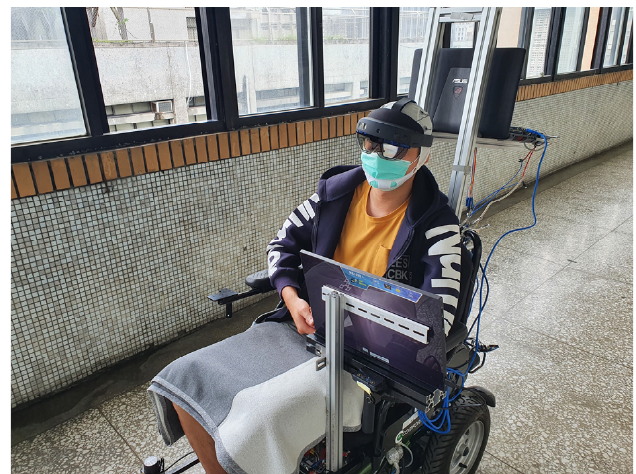
Figure 8. The configuration for the experiment using MR goggles.